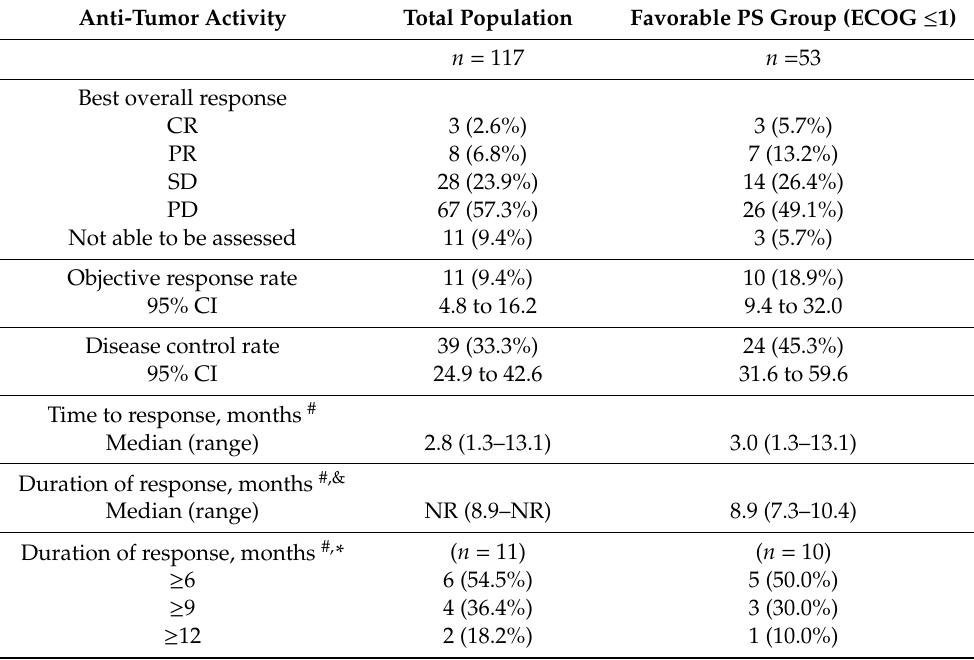
Table 2. Tumor responses assessed by RECIST v.1.1 ( n = 117).